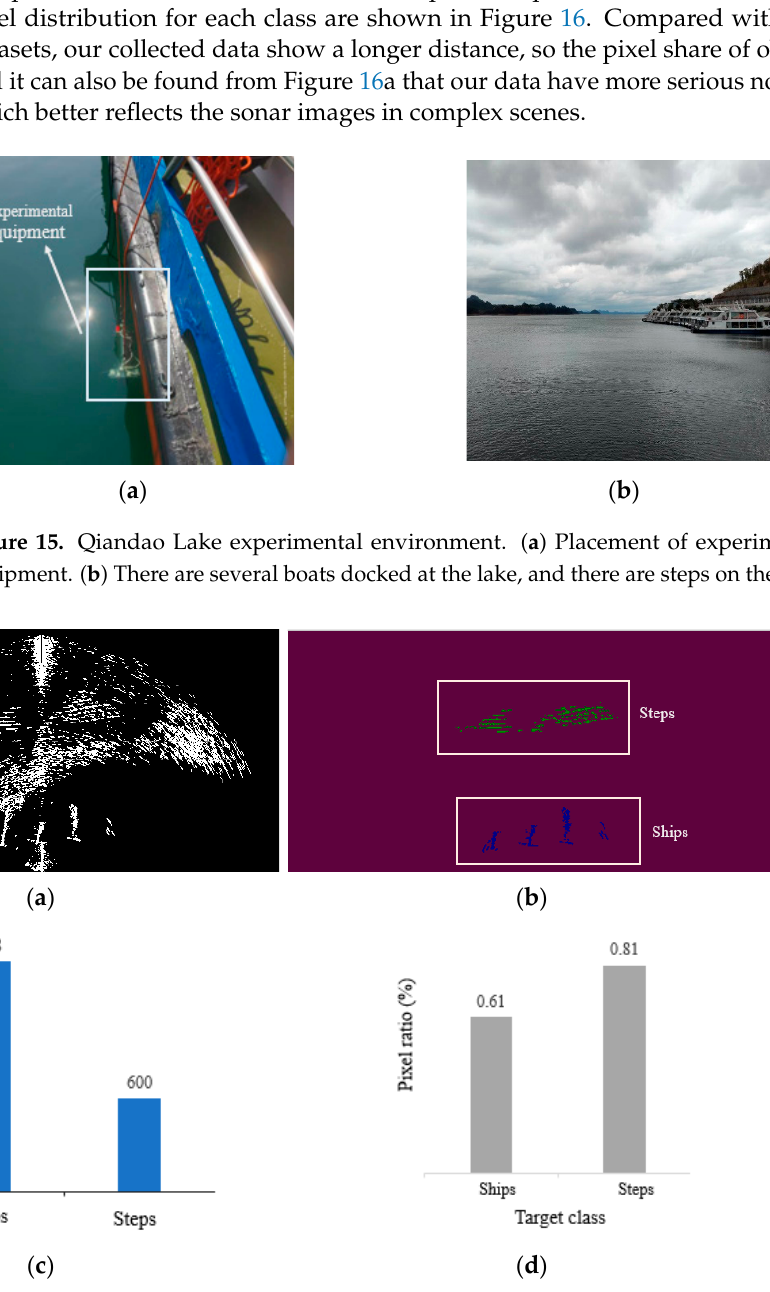
Figure 16. Data for each class in the image. ( a ) Acquired sonar images. ( b ) The green part of the marked image information is the step, and the blue part is the ship. ( c ) Number of images accounted for by each class. ( d ) The average of the ratio of pixels occupied by that class in the image where that class exists.